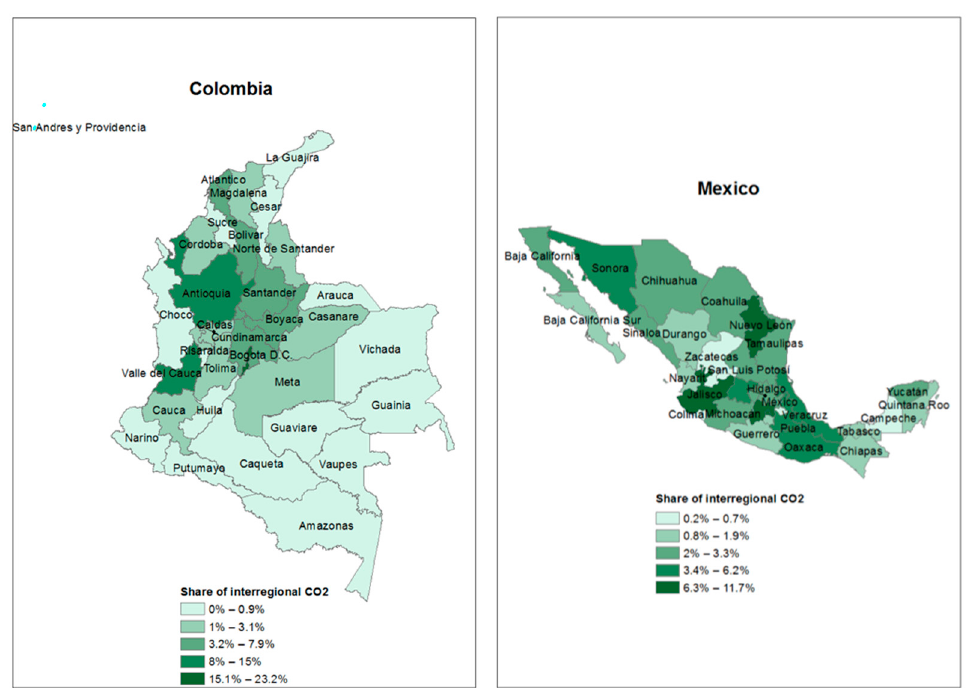
Figure 3. Share of CO 2 content embedded in interregional trade (from regional source). Note: The maps of the four analyzed countries are presented, with the regional aggregation adopted in the study. The upper left map refers to the Brazilian states, the upper right to the Chilean regions, the lower left to the Colombian departments, and the lower right to the Mexican states.